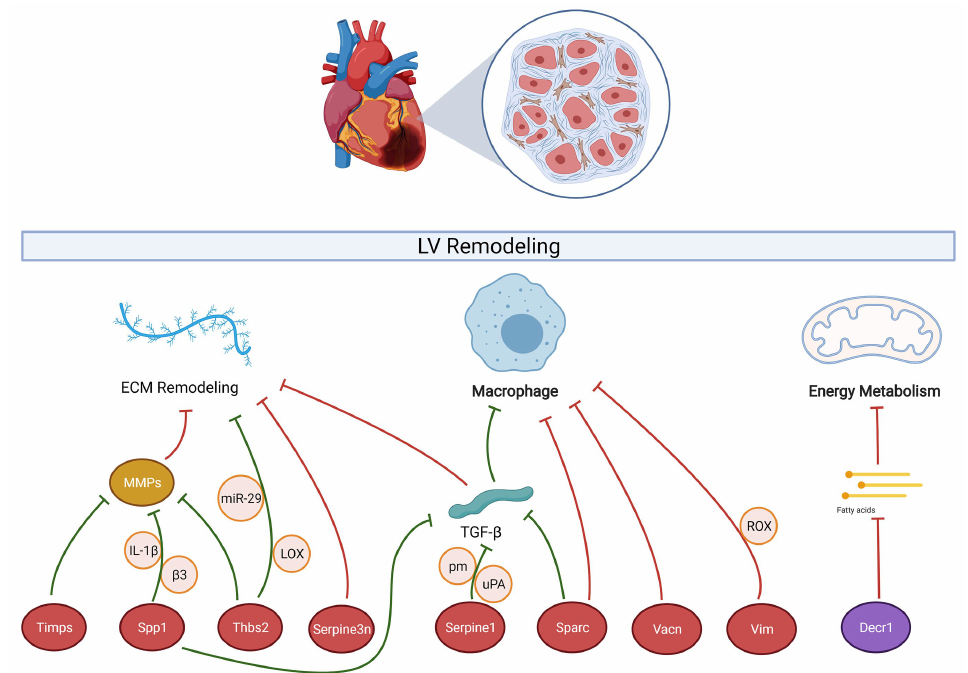
Figure 8. Mechanisms of myocardial remodeling after AMI by the 10 hub genes. Up-regulated hub genes are indicated by red ovals and down-regulated hub genes are indicated by purple ovals. Red arrows represent positive regulation and green arrows represent negative regulation. Circles represent intermediate or interacting factors in the regulatory process. “MMPs”, “TGF- β ”, and “Fatty acids” are regulatory mediators, while “ECM remodeling”, “Macrophage”, and “Energy Metabolism” are regulatory pathways.